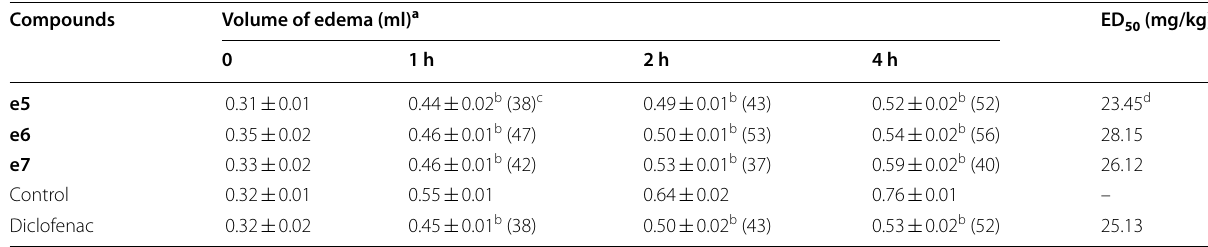
Table 40 Anti-inflammatory activity of pyrimidine derivatives Comp.